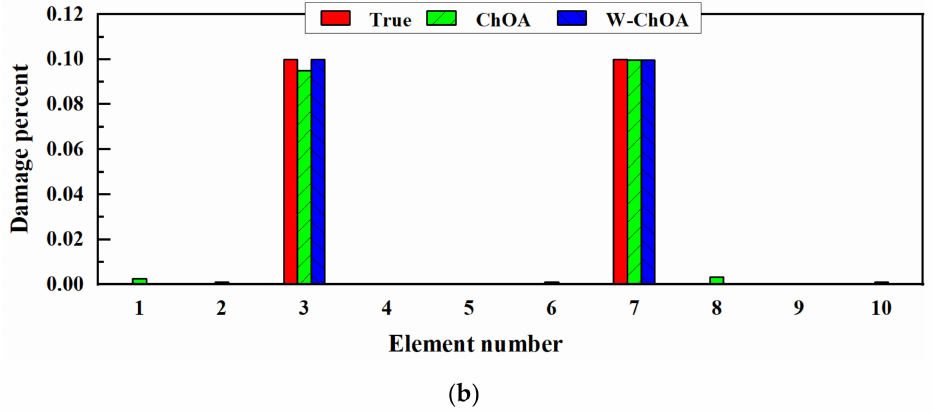
Figure 10. Double damages detection results of the simply supported beam by two chimp-based optimization algorithms. ( a ) 5% noise level. ( b ) 10% noise level.